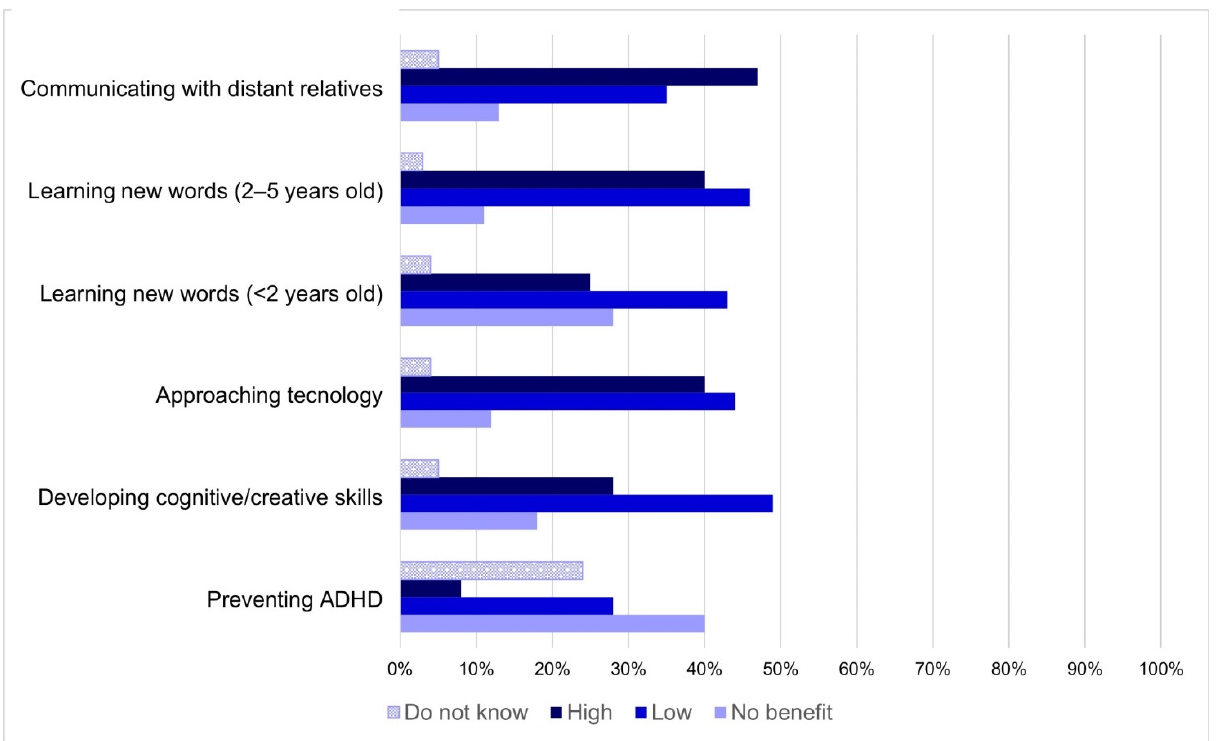
Figure 2. Evaluation of benefits obtainable from certain situations regarding the use of MDs by children under the age of 5, using a 7-point Likert scale. No benefit = score 1, Low = scores 2, 3, 4, High = scores 5, 6, 7. About risks (Figure 1), having eye irritation ( n = 2582; 83%), confusing virtual reality with real world ( n = 2294; 74%) and having sleep disorders ( n = 2015; 65%) were situations considered most risky, as indicated by respondents. Becoming obese was considered a high risk by 51% ( n = 1598) and a low risk by 32% ( n = 981) of respondents. Thirty-one percent ( n = 956) did not know to quantify the risk of developing epilepsy and the same percentage rated the risk high. Sixty percent of the sample ( n = 1857) reported that there was no risk related to developing celiac disease with the use of MDs and 36% ( n = 797) were not able to give a score. Excluding “becoming epileptic” and “coeliac”, in all the other items, more than 50% of respondents rated high risk. Communicating with distant relatives ( n = 1448; 47%) was the situation most per- ceived as beneficial by participants. All other possible benefits related to the use of MDs were perceived as high by less than 50% of the sample (approaching technology, learning new words, developing cognitive/creative skills). Preventing ADHD (Attention Deficit Hyperactivity Disorder) was not indicated as a benefit by 40% of the sample. However, 25% ( n = 755) of respondents were not able to give a score. Twenty-eight percent of re- spondents ( n = 869) stated that learning new words was not a benefit related to the use of MDs by children under the age of 2 years, and to a greater extent when referring to chil- dren aged 3–5 years (11%, n = 349) ( p < 0.001). The distribution of responses for each risk or benefit did not change substantially when non-parents, 0–5-year-old children’s parents and parents of children over 5 years were considered separately (data not shown in figures). Questions related to reasons and time of use of MDs by children aged 0–5 years were specifically addressed to parents of children under 5 years. Excluding 32 parents who did not complete this part of the questionnaire, the analysis was carried out on 1869 parents. Of them, 587 parents had only children aged 0–2 years, 994 had only children aged 3–5 years and 288 had children in both age groups.